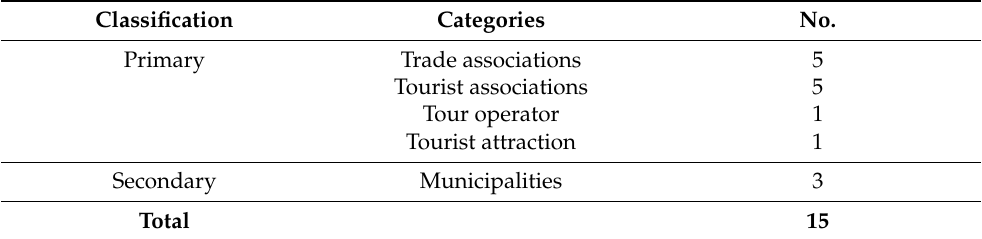
Table 1. Stakeholders involved in the study.